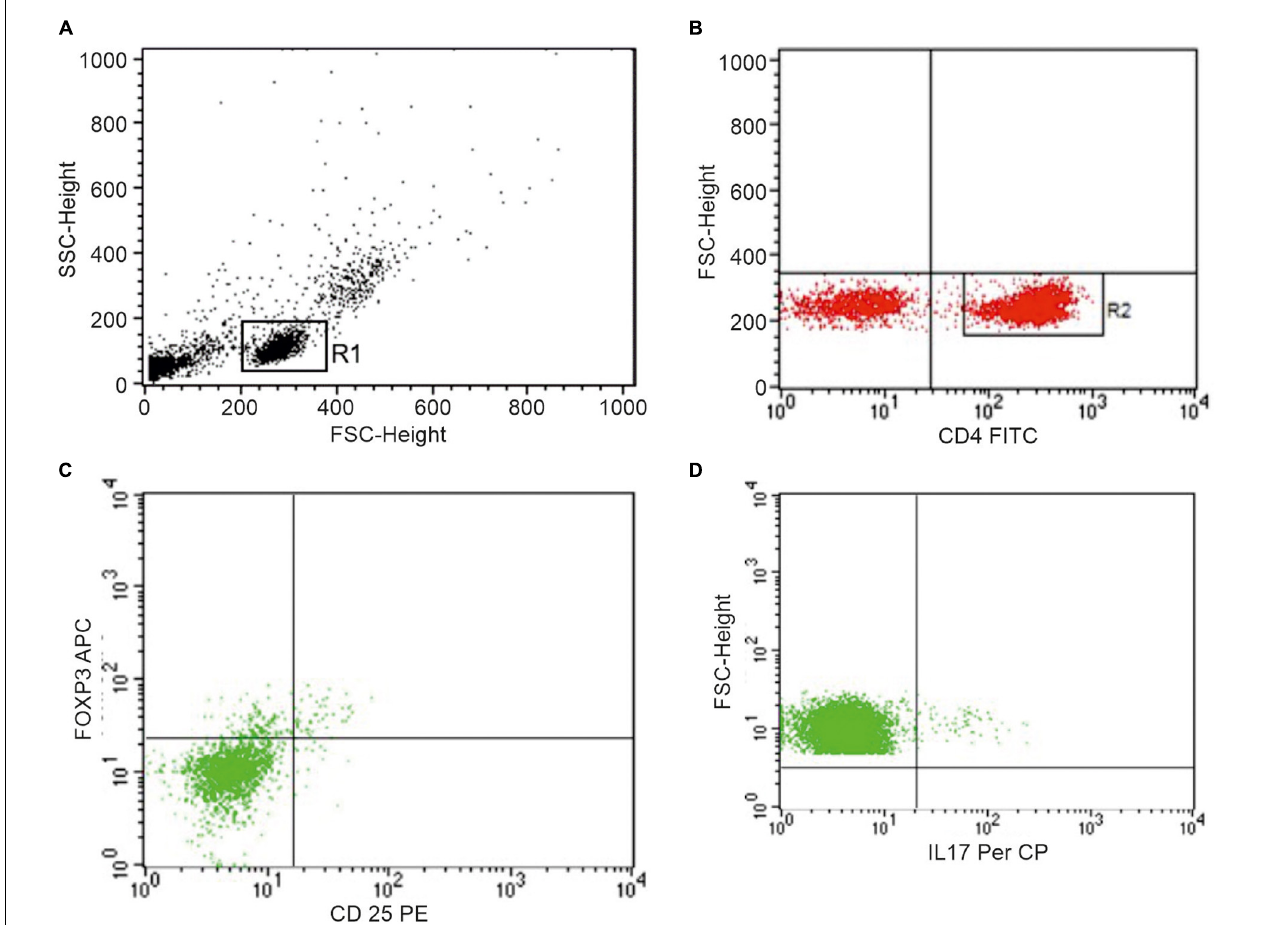
FIGURE 1 | Representative dot plots of peripheral blood lymphocytes from one patient showing the gating strategy to identify Th17 and Treg cells. (A) Live cells, gated for cell death and debris exclusion, were then gated as lymphocytes (R1) based on morphological parameters (SSC, side scatter; FSC, forward scatter). (B) Identification of CD4+ lymphocytes (R2) within the R1 population. (C) Identification of Treg cells and (D) Th17 cells within the R2